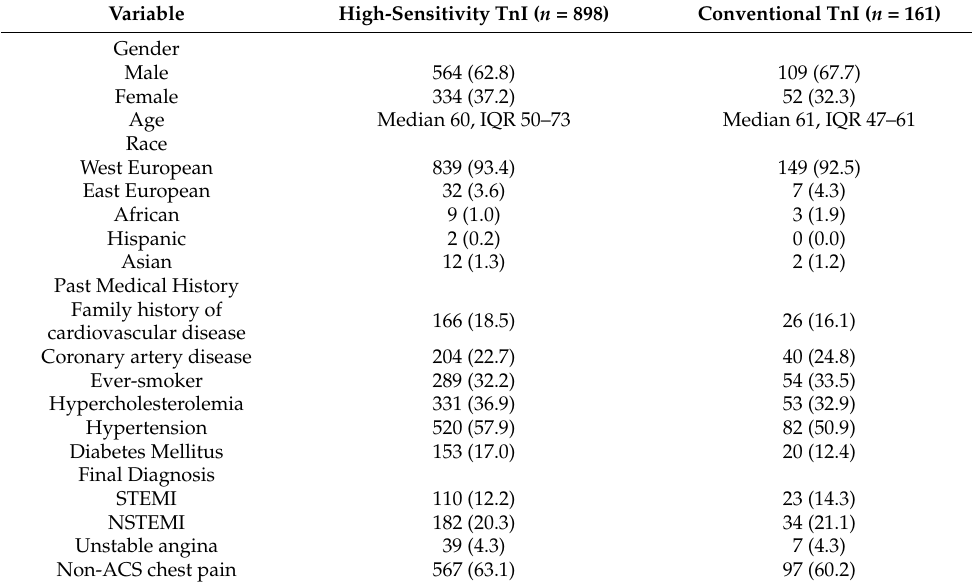
Table 1. Baseline characteristics of patients with hsTnI versus conventional TnI 1 .